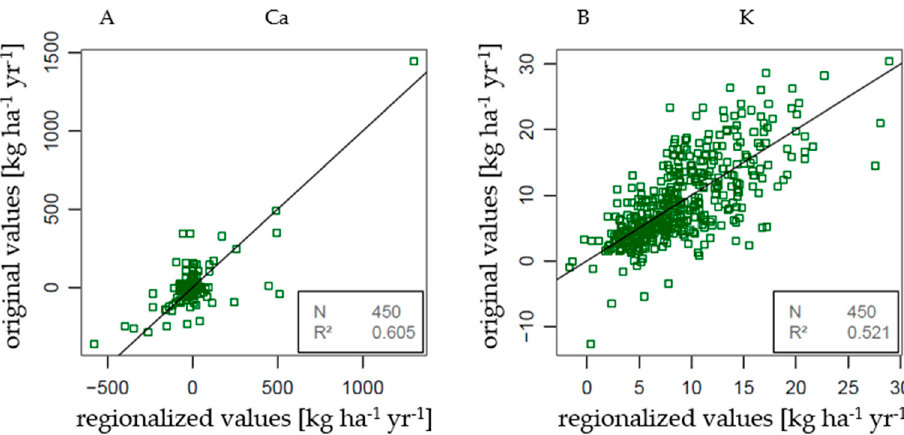
Figure A6. Scatter diagram of regionalized calcium (Ca, ( A )) and potassium (K, ( B )) balances versus balances calculated from measured NFSI data ( y axis). Black line = 1:1 reference.